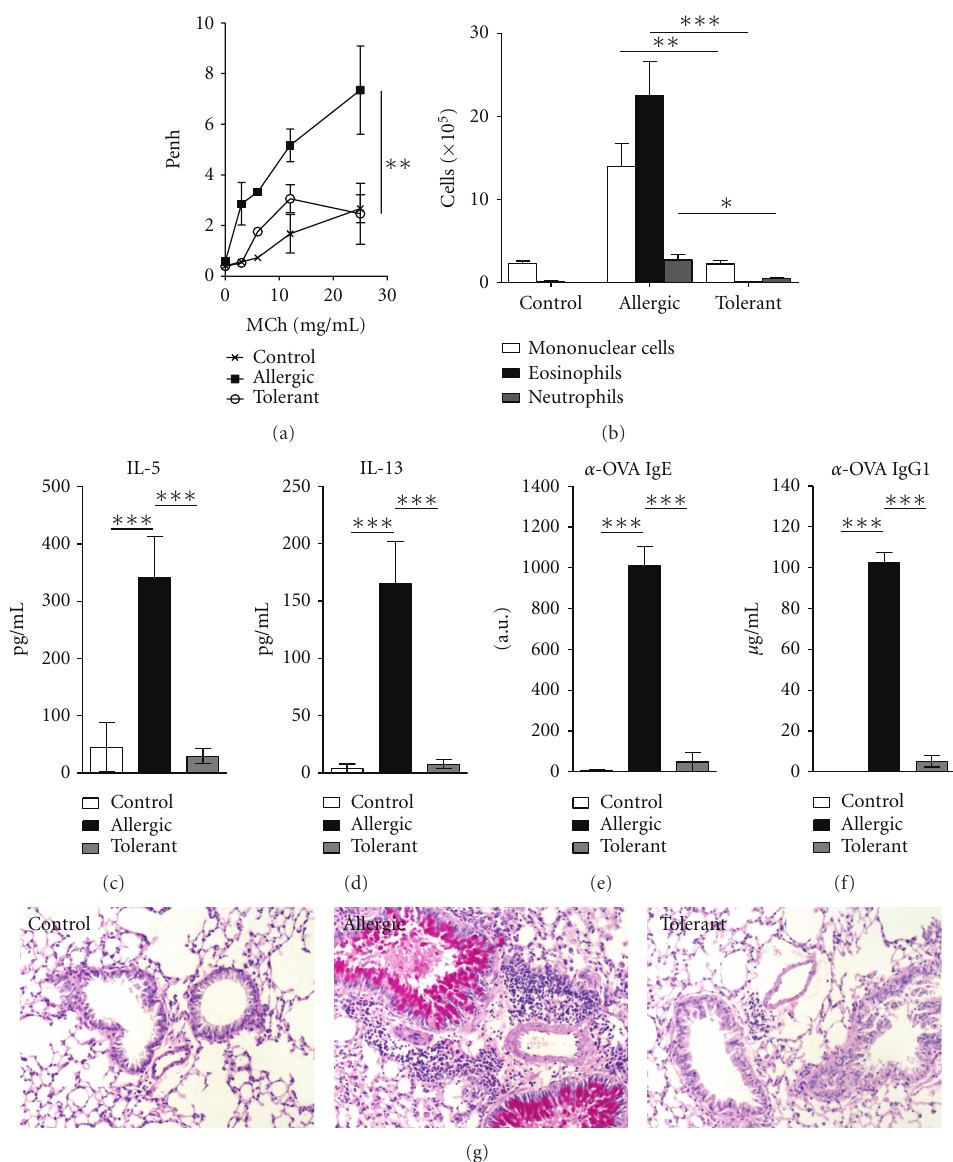
Figure 1: Oral tolerance prevents airway allergic disease. (a) Respiratory pattern to increasing dose of methacholine (MCh) in control, allergic, or tolerant BALB/c mice 24h after the last OVA challenge. (b) BAL di ff erential cell counts. Quantification by ELISA of (c) IL-5, (d) IL-13 in the BAL fluid, and (e) anti-OVA IgE, (f) IgG1 in the serum. (g) Histology of lung sections at 100x. Lung parenchyma inflammation and mucus production by goblet cells are shown in representative lung sections stained with hematoxylin/PAS. Values represent the means ± SEM for groups of five mice and are representative of more than three experiments. Significant di ff erences ∗ P < 0 . 05, ∗∗ P < 0 . 01, and ∗∗∗ P < 0 . 001 are